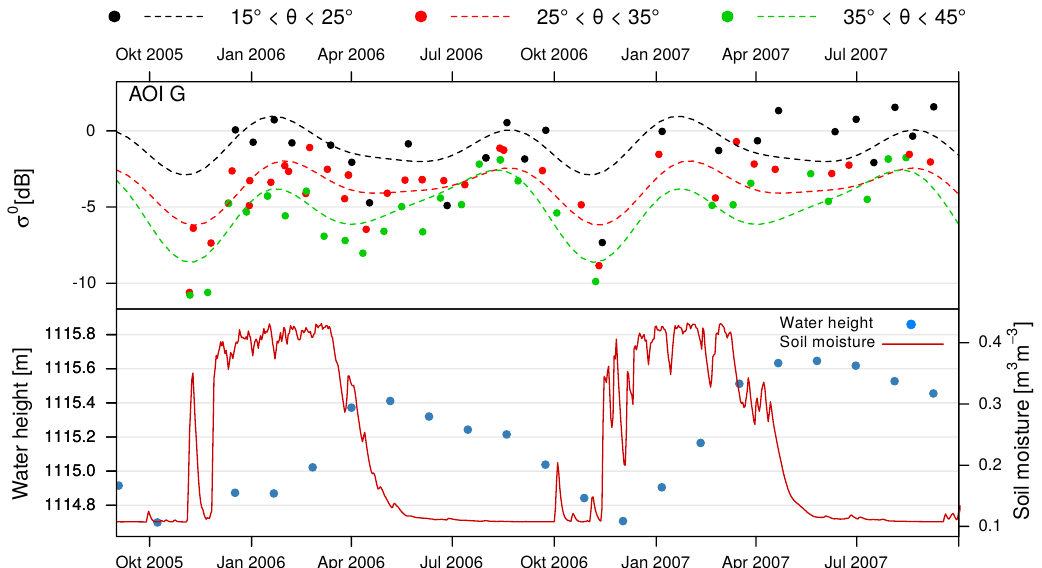
Figure 6. ASAR σ 0 time series for different local incidence angle ranges in AOI G ( top ) as well as soil moisture from ERA-Interim/Land and altimeter water heights in the Lukanga Swamps ( bottom ). Dashed lines show fitted harmonic